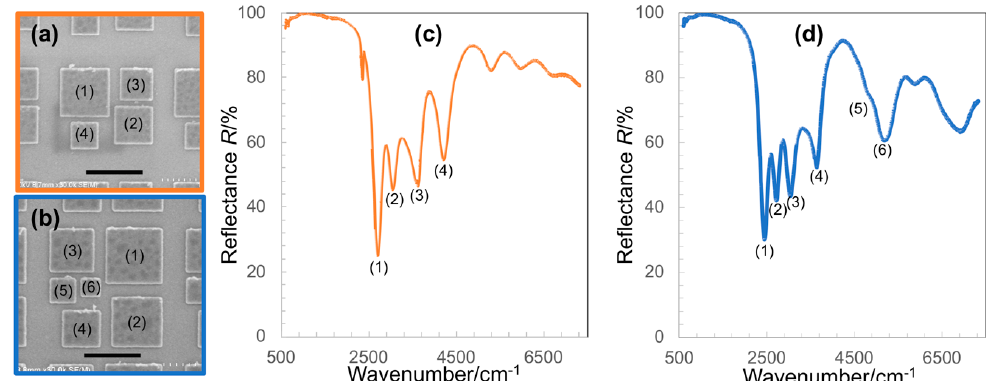
Figure 4. ( a , b ) Typical top-view SEM images of multi-band metal-insulator-metal (MIM) structures, ( c , d ) reflectance spectra of the corresponding MIM structures in ( a , b ) revealing absorbers of multi-bands that can be readily tuned throughout the mid-IR regime. The scale bar in ( a , b ) is 1 μ m.